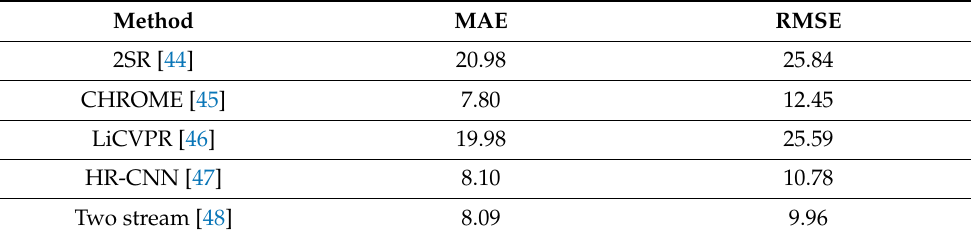
Table 4. Benchmark performance of the various rPPG-prediction models on the COHFACE dataset [25]. 2SR, CHROME, and LiCVPR are the traditional signal processing-based methods, while HR-CNN and Two stream are data-driven and machine learning-based